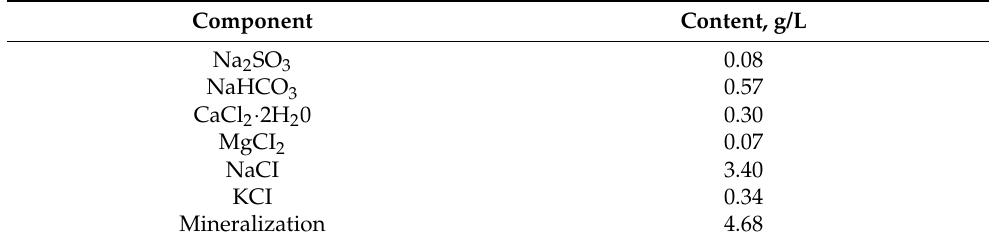
Table 3. Composition of the model water